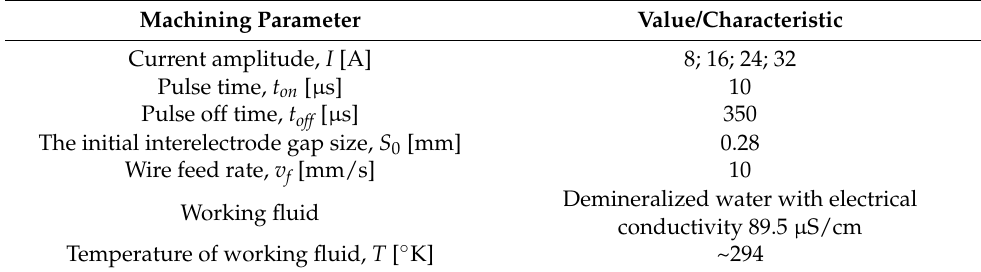
Table 3. Machining conditions for the WEDM process. Machining Parameter Value/Characteristic Current amplitude, I [A] 8; 16; 24; 32